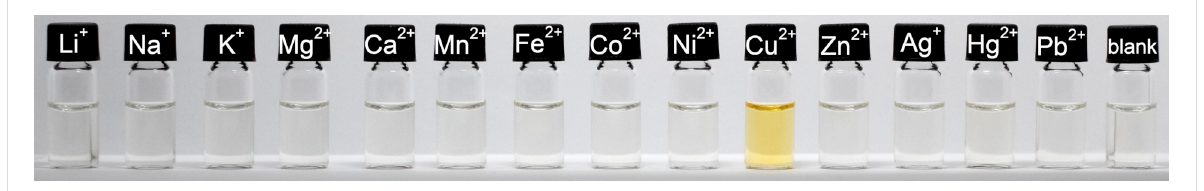
Figure 1: Colors of the solutions resulting from the addition of metal ions ( c = 50 µM) to derivative 3a ( c = 20 µM in MeCN); t = 1 h.